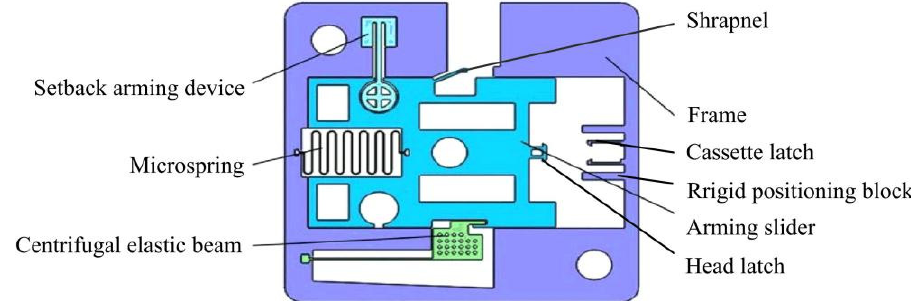
Figure 2. Structure designed by Li [20].